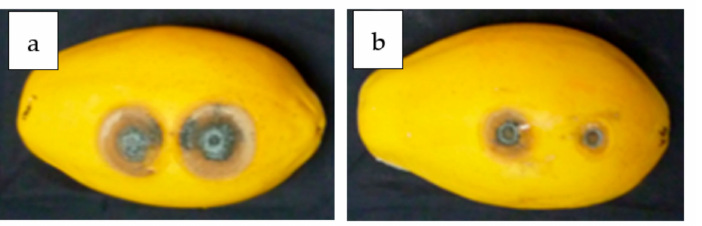
Figure 2. Radial growth of C. gloeosporioides in papaya wounds treated with antagonist yeast after six days of inoculation; ( a ) papaya wound without yeast treatment, ( b ) papaya wound treated with F001